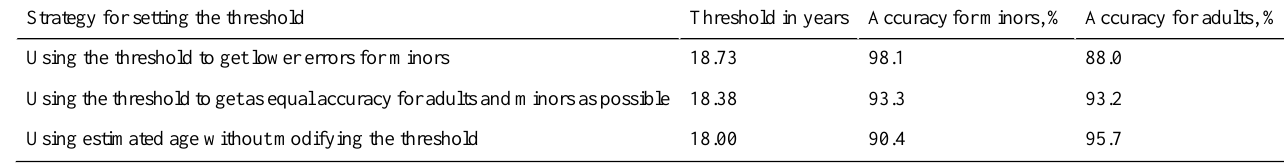
Table 4. Accuracies for minor versus adult classification of male subjects.